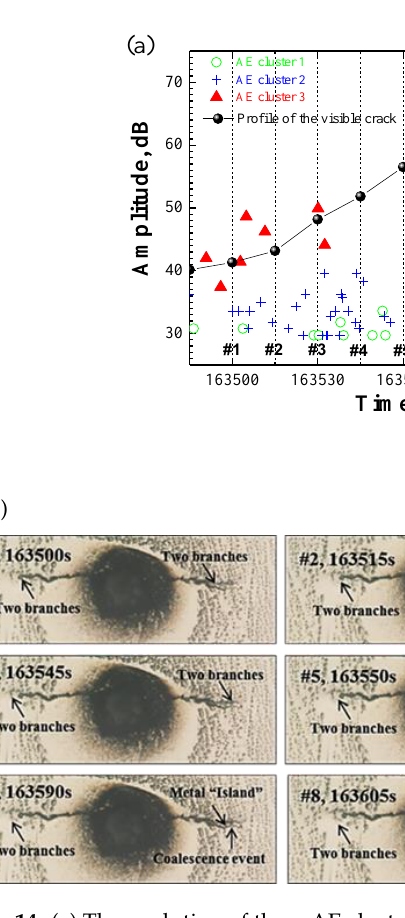
Figure 14. ( a ) The evolution of three AE clusters during the selected duration; ( b ) A phenomenon of crack-branch coalescence during crack propagation in specimen B. Marked numbers are corresponding to Figure 14a. Online version in color.